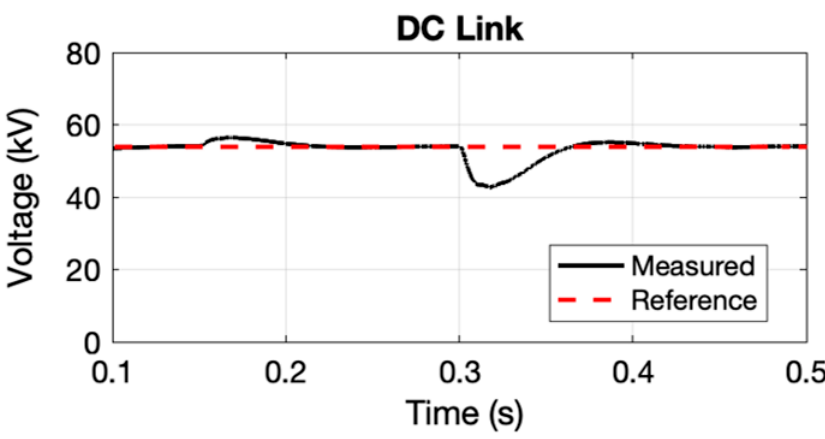
Figure 25. DC link voltage variations due to the different active and reactive power setpoints.